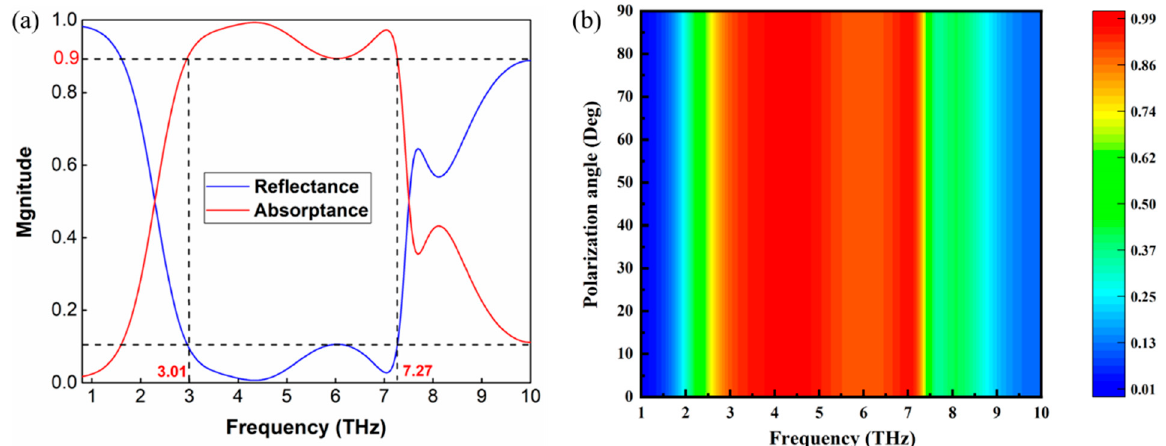
Figure 2. ( a ) Optimal absorption and reflection spectrum and ( b ) absorption spectrum at different polarization angles when σ = 2 × 10 5 S/m.